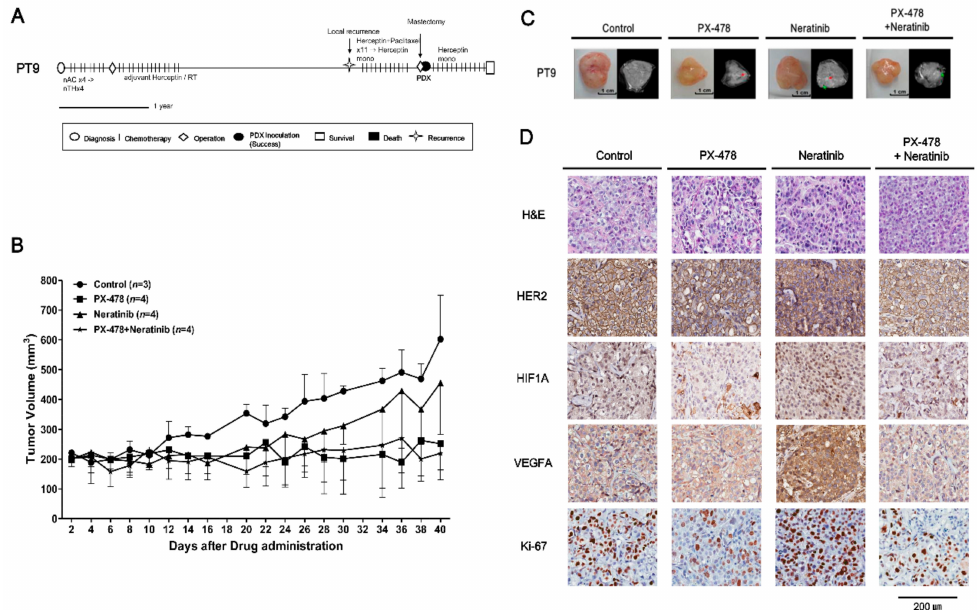
Figure 4. In vivo e ffi cacy of PX-478 and neratinib against PDX models from PT9 (HR − / HER2 +